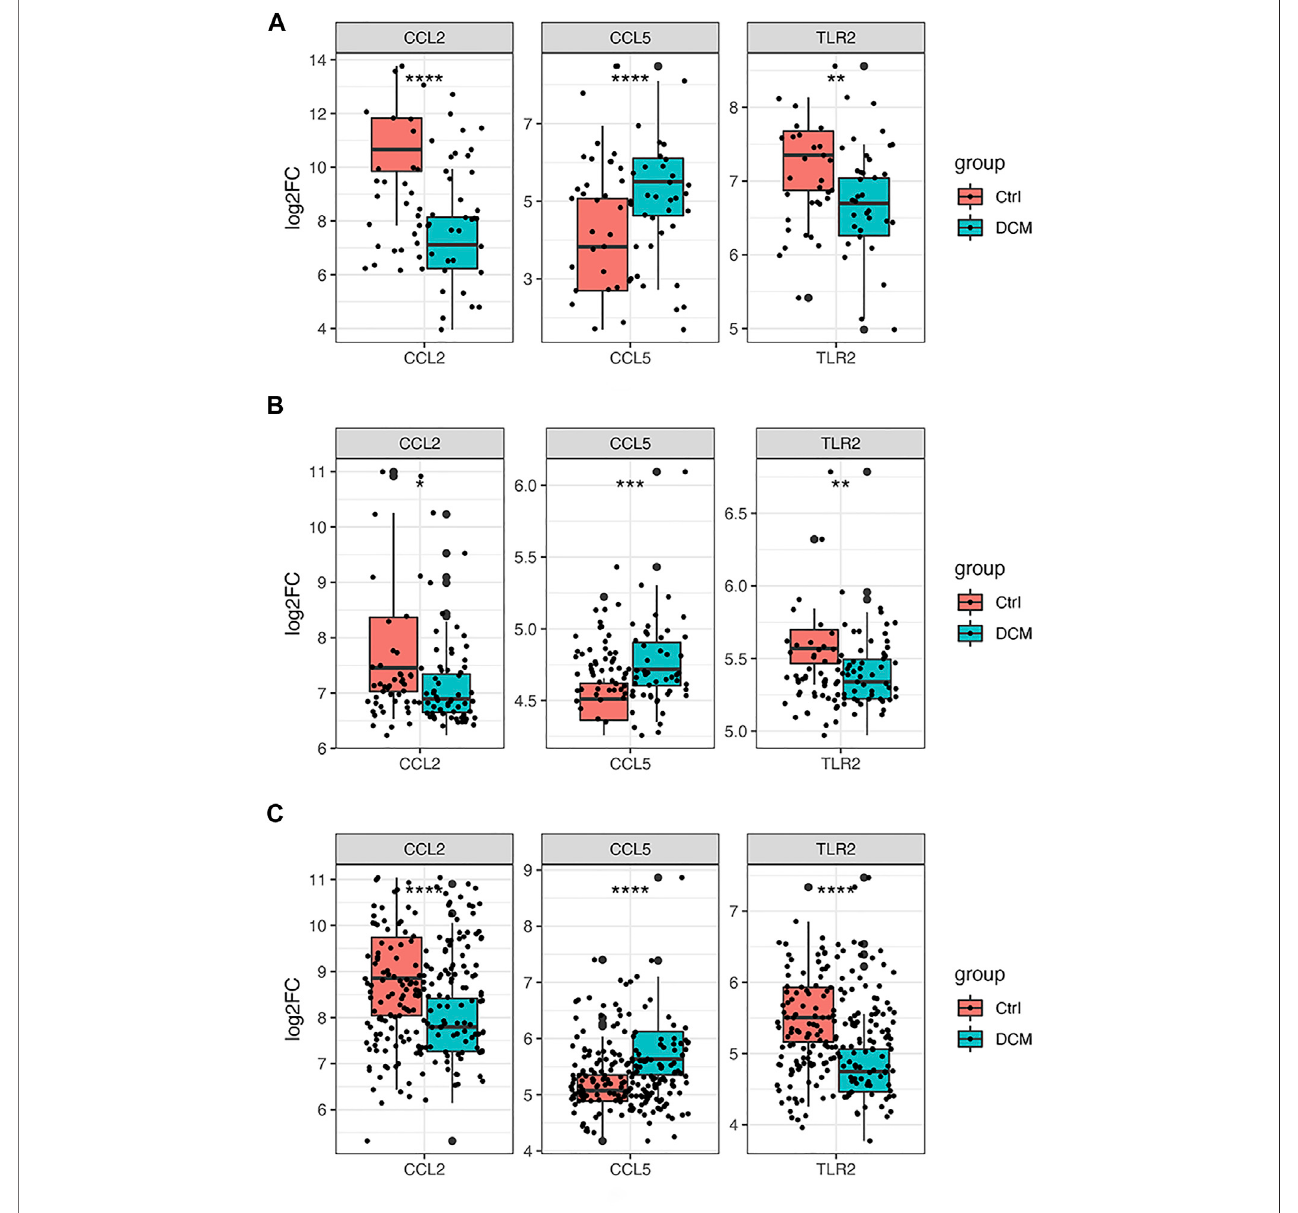
FIGURE 7| Gene expression of the three selected hub genes (A) Boxplot of the three selected hub genes in merged dataset (B) Boxplot of the three selected hub genes in GSE5406 (C) Boxplot of the three selected hub genes in GSE57338. * p < 0.05, ** p < 0.01, *** p < 0.001 **** p < 0.0001.